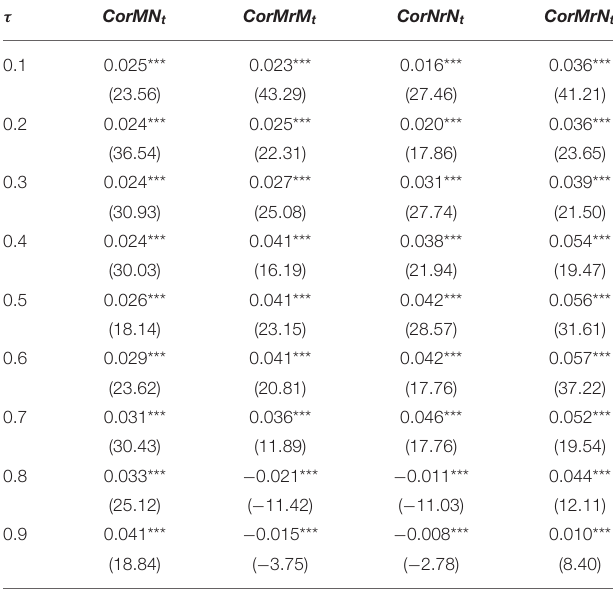
TABLE 6 | The results of the quantile regression of the dynamic correlation on the stock market.